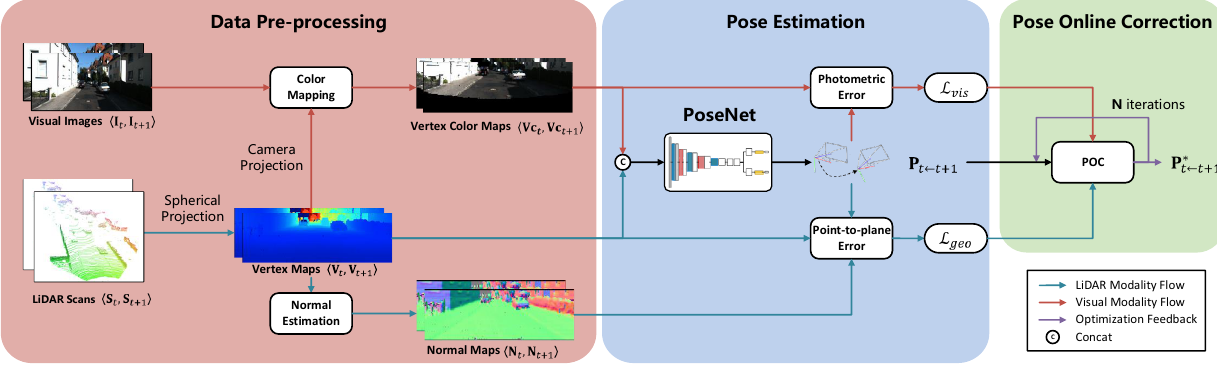
Figure 1. An overview of the proposed method. It consists of the data pre-processing, pose estimation, and online pose-correction modules. Given two consecutive LiDAR scans (cid:104) S t , S t + 1 (cid:105) and visual images (cid:104) I t , I (cid:105) , the data pre-processing step produces vertex maps (cid:104) V t , V t + 1 well as vertex color maps (cid:104) Vc t , Vc t + 1 (cid:105) . The vertex maps and vertex color maps are concatenated